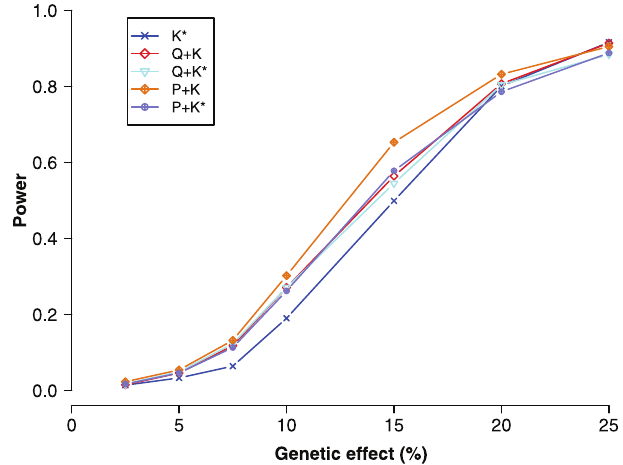
Figure 4. Power to Detect Associations Using a Nominal 0.1% Significance Level The QTN is assumed to lie within a sequenced haplotype, but power is nonetheless poor even for major QTL.